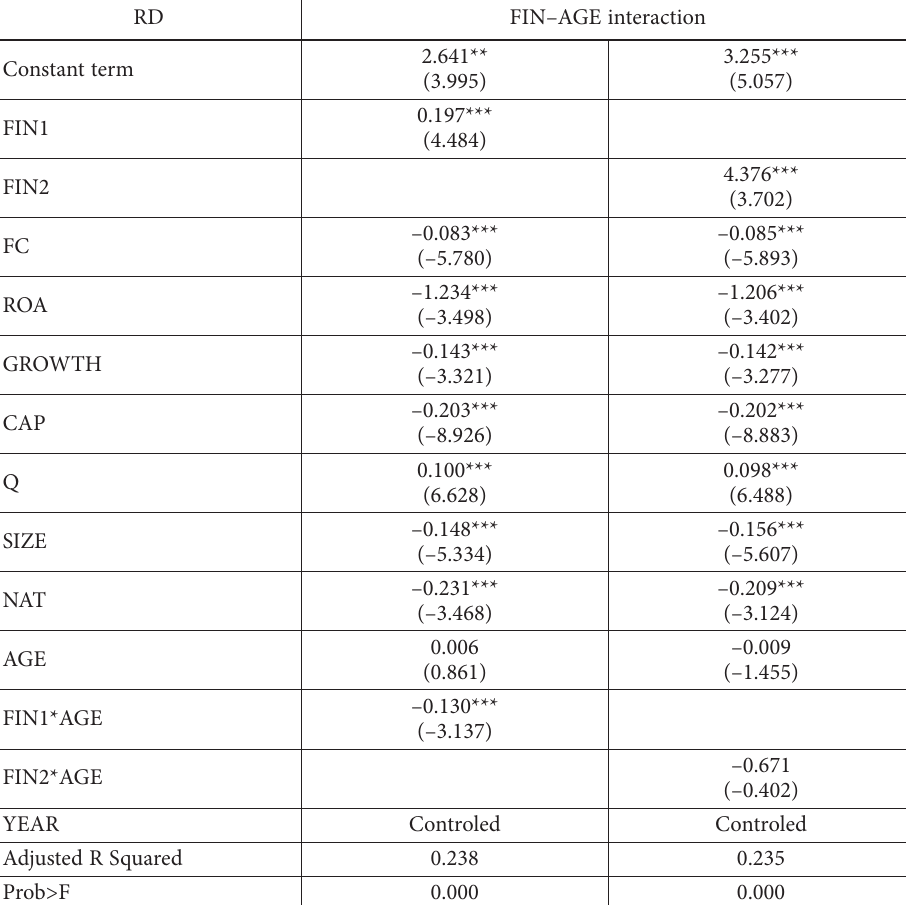
Table 11. Results of Model